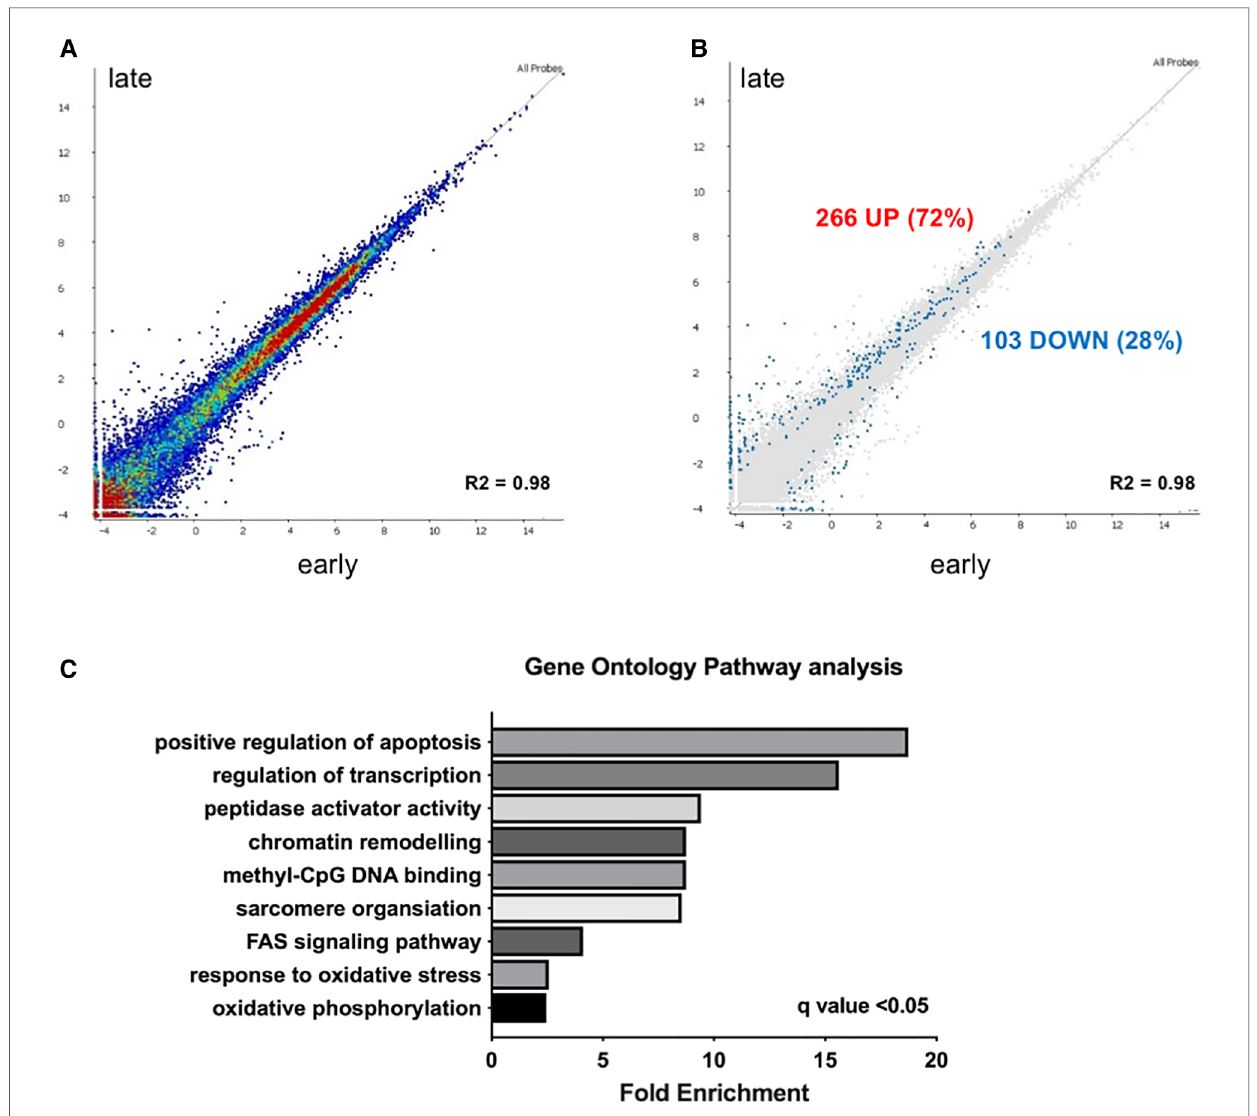
FIGURE 1 Transcriptome analysis reveals upregulation of epigenetic modi fi ers in early vs. late chemotherapy-induced heart failure in myocardial patient biopsies. ( A ) relative upregulation of genes in early vs. late chemotherapy-induced heart failure endomyocardial biopsies; ( B ) in total 266 genes (72%) were upregulated. Relative downregulation of genes in early vs. late chemotherapy-induced heart failure endomyocardial biopsies, in total 103 genes (28%) were downregulated; ( C ) gene ontology analysis shows the pathways that are preferentially enriched in early vs. late